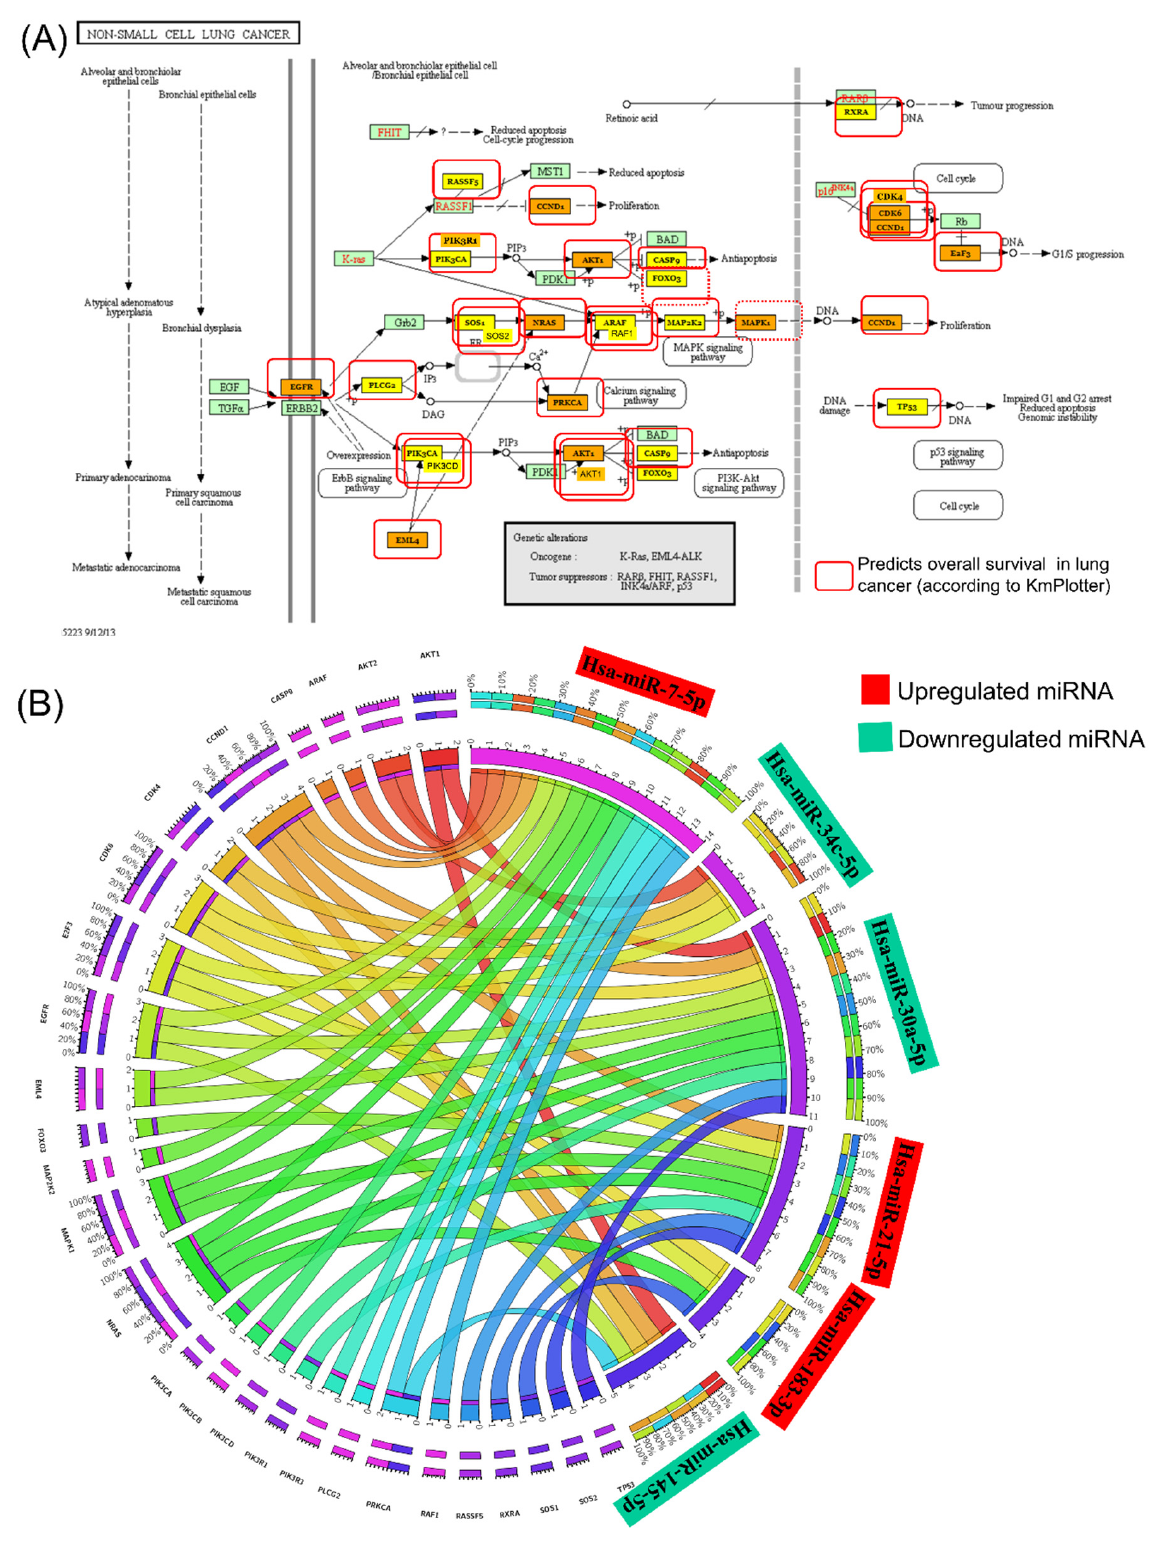
Figure 3. NSCLC signaling. ( A ) NSCLC network performed using KEGG pathways via DIANA- miRPath v3.0. Yellow are genes targeting one miRNA, and orange are genes targeting at least two miRNAs. Red squares mark the genes correlated with the overall survival of NSCLC patients using the KM plotter online tool. ( B ) Circos plot emphasizes the interconnection with the downregulated transcripts (miR-145-5p, miR-34c-5p, and miR-30a-5p) and three upregulated transcripts (miR-21-5p, miR-7-5p, and miR-183-3p) and critical genes related to this signaling.